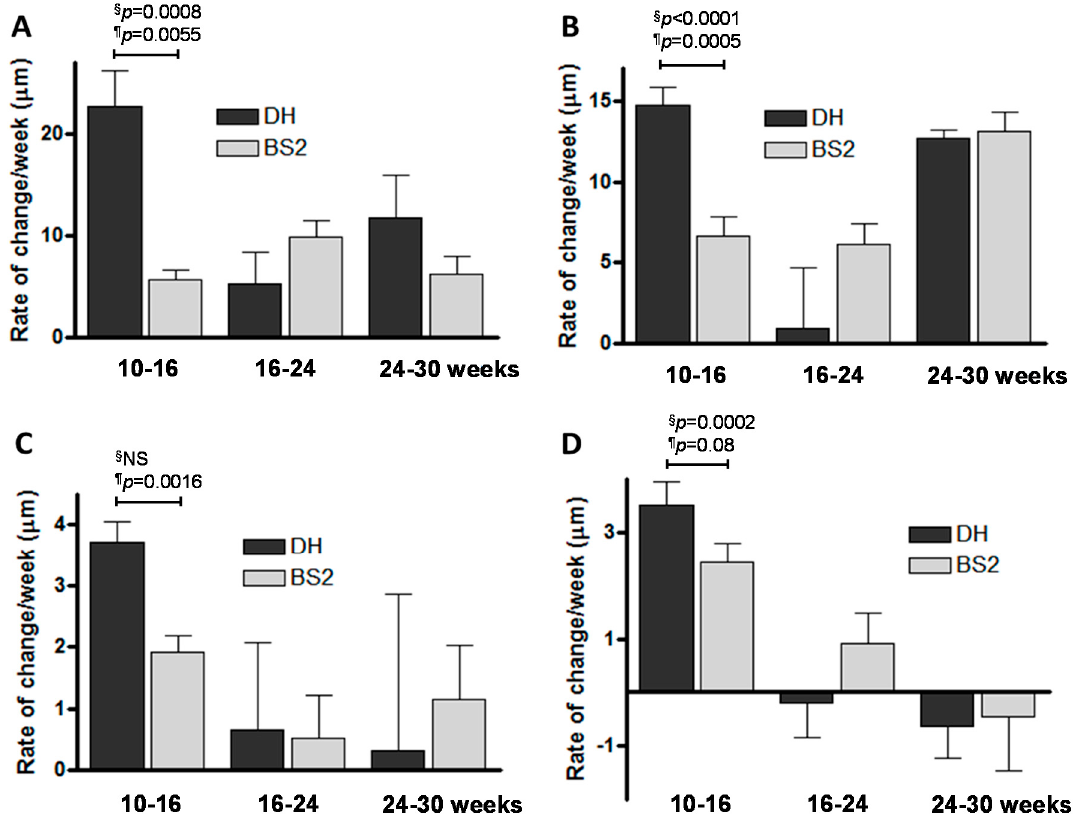
Figure 3. Rate of change in subchondral bone thickness of DH and BS2 guinea pigs for intervals 10–16, 16–24 and 24–30 weeks. ( A ) Medial SbpTh; ( B ) lateral SbpTh; ( C ) medial TbTh and ( D ) lateral TbTh. The rate of change in subchondral bone thickness between strains over time intervals were ranked and compared using 1-way ANOVA § and Student t -test ¶ . The p -values shown are for the earliest time point only.